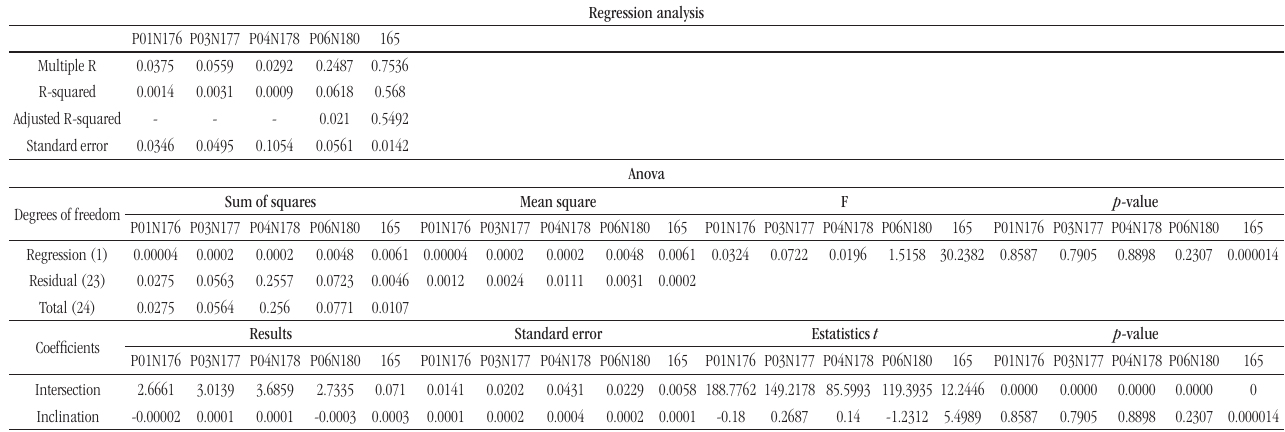
taBLE 2 − Results of the simple linear regression analysis applied to the mean values of the three determinations of serum from different batches of anti-treponemal IQC submitted to the 174 F/T cycles, with 95% of confidence interval Regression